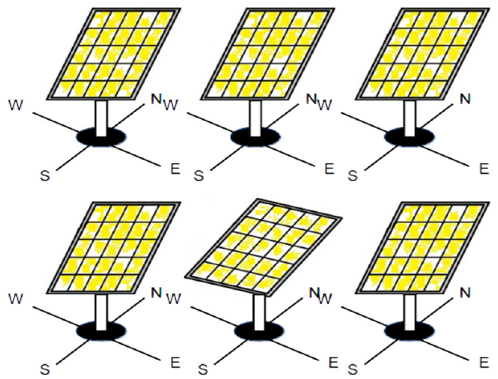
Figure 2. Strategy proposed for the detection of a tracker fault, namely through the comparison of the slopes between the PV